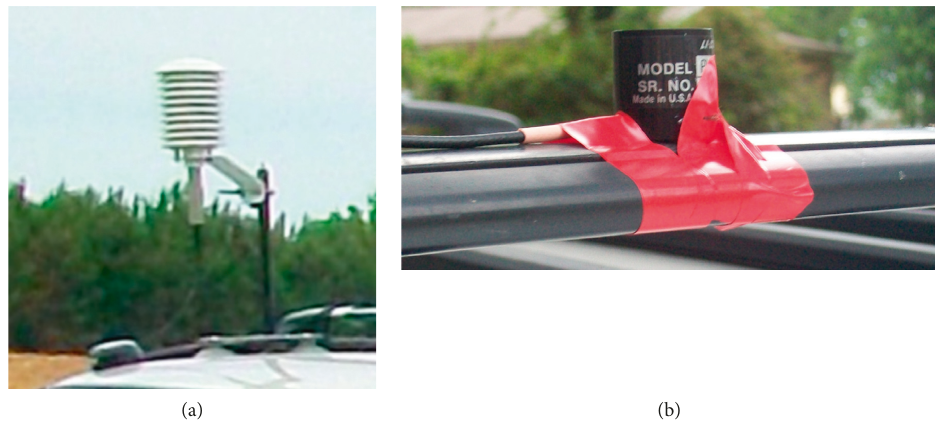
Figure 1: (a) HMP45C in Gill shield and Garmin GPS. (b) LI-200 pyranometer mounted on vehicle